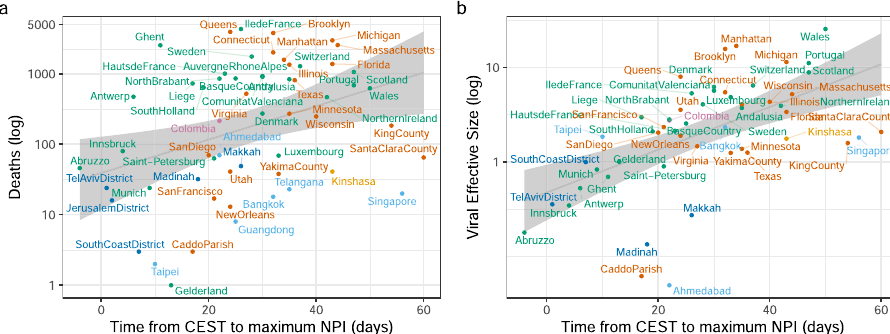
Fig. 4 Relationship between epidemic severity and viral effective population size, and the estimated time to maximum NPI. a Cumulative deaths within a month following max NPI versus time to max NPI. a Viral effective population size (estimated at max NPI) versus time to max NPI. Colours are different for each world region (see Supplementary Fig 4). The grey line indicates the linear regression line (mean fi tted values) and 95% con fi dence interval. CEST central epidemic seeding time, NPI non-pharmaceutical